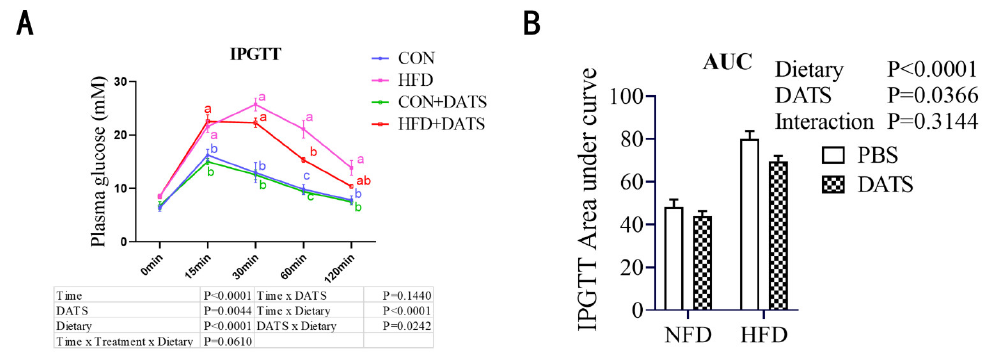
Figure 2. DATS treatment can improve glucose tolerance of obese mice. ( A ) IPGTT, 2 g/kg glucose